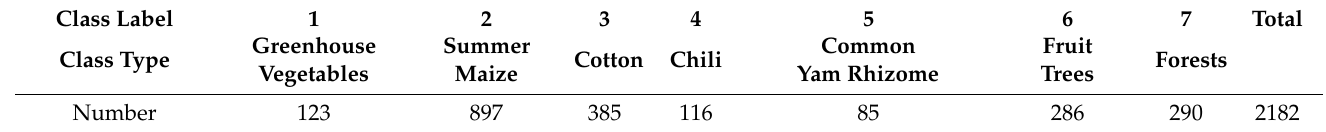
Table 1. Number of samples per type.